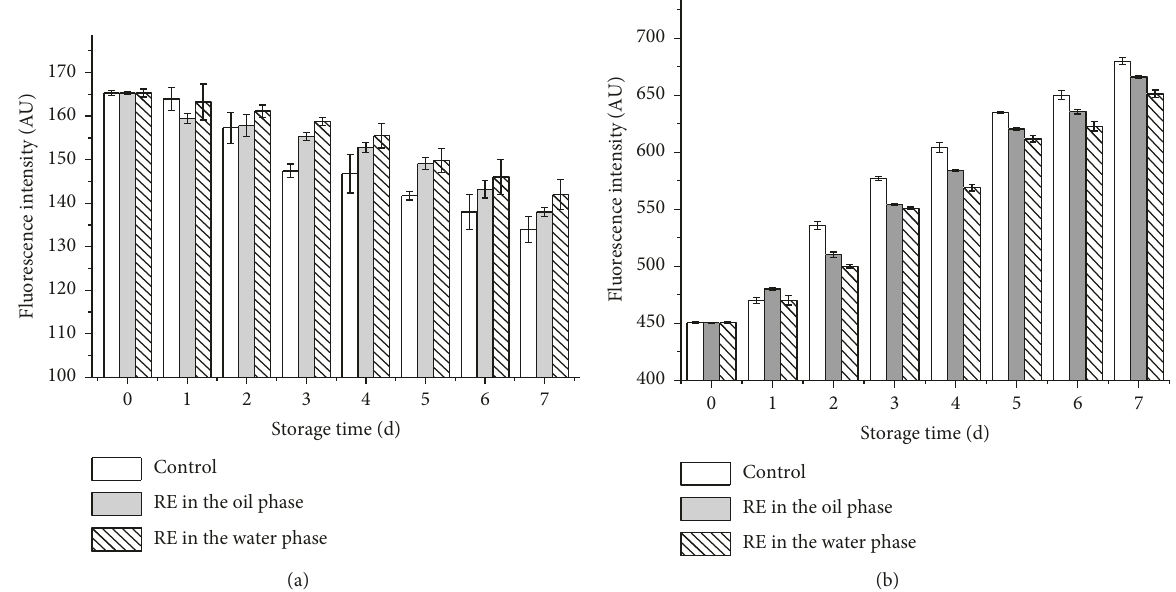
Figure 5: Decrease of tryptophan fluorescence (a) and increase of WPI oxidation products fluorescence (b) in WPI-stabilized lutein emulsions with different addition methods of rosemary extract (RE) (in the oil or water phase) during the storage at 55 ° C. Data points represent means ( n � 3) ± standard